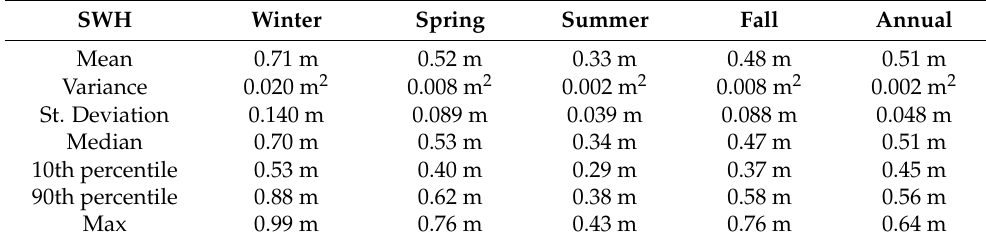
Table 3. SWH seasonal statistic parameters. Right-side column reports the annual mean.